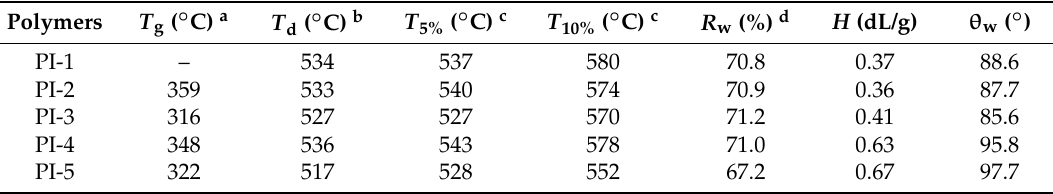
Table 1. Thermal properties, viscosity and contact angle of polyimides.